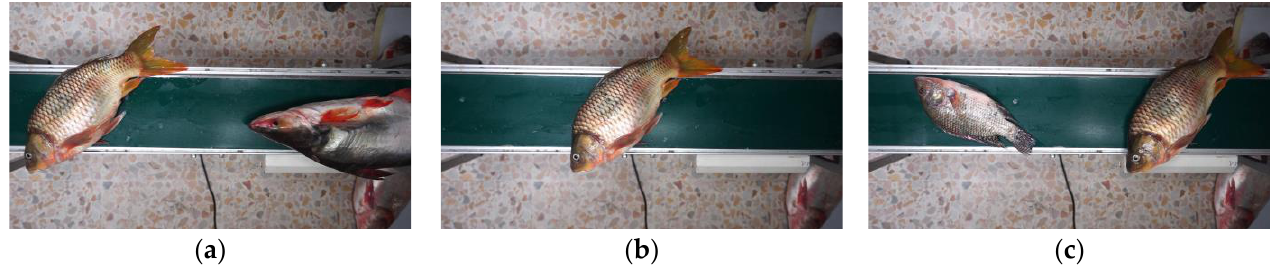
Figure 3. Example of extracting images for one fish from the low-speed video: ( a ) when the fish appears in its entirety; ( b ) at the exact center position; and ( c ) just before the fish’s snout or tail hits the right-hand frame border to leave the frame. Table 3. Images for training and augmentation.